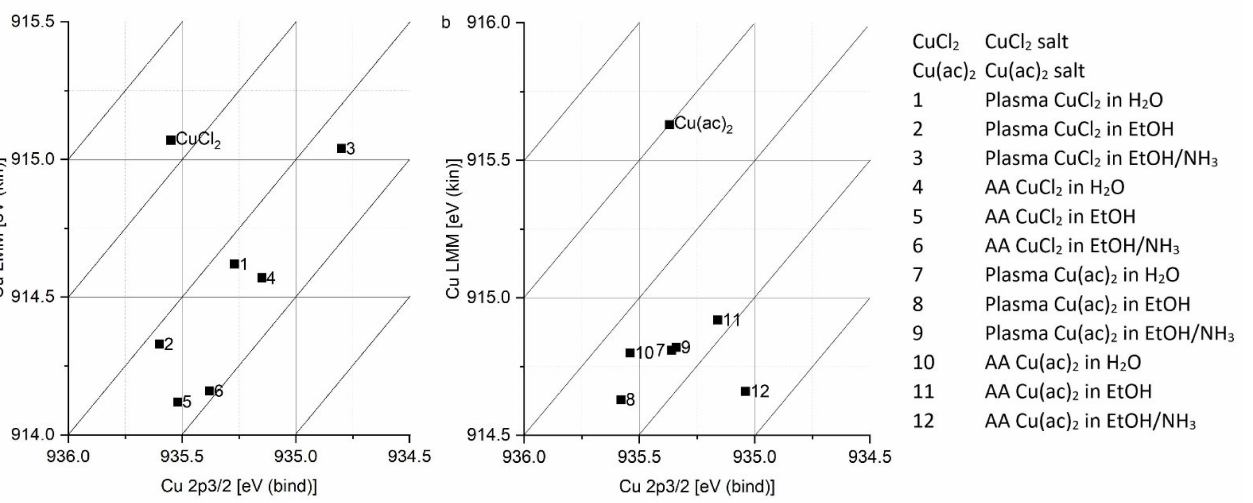
Figure 5. Wagner plots of the Cu 2p3/2 signal and the Cu LMM Auger signal, retrieved from XPS data. ( a ) CuCl 2 and surfaces loaded with CuCl 2 . ( b ) Cu(ac) 2 and surfaces loaded with Cu(ac) 2